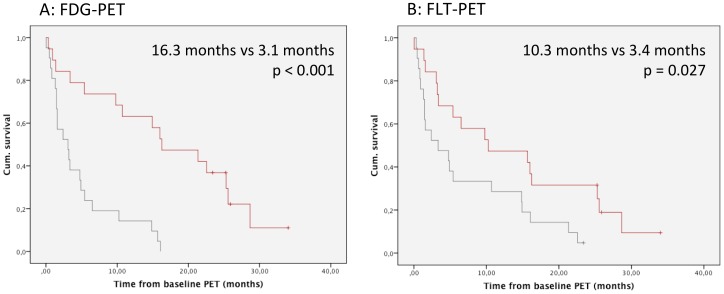
Kaplan Meier curves showing overall survival depending on SUVmax values.A) Overall survival of patients with high (>6.7; grey) or low (<6.7; red) baseline SUVmax in FDG-PET. (B) Overall survival of patients with high (>3; grey) or low (<3; red) baseline SUVmax in FLT-PET.